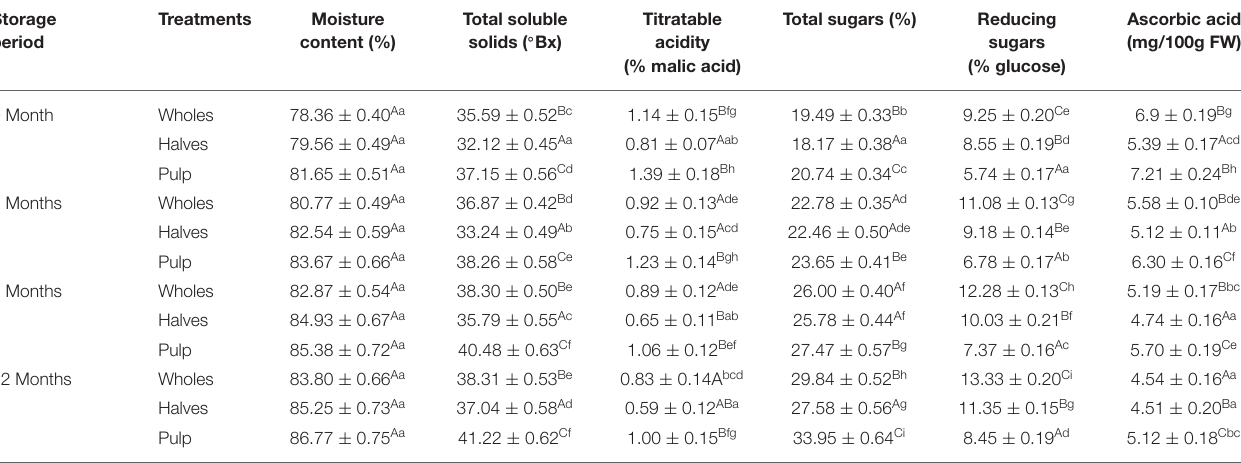
TABLE 1 | Effect of canning and storage on physiochemical properties of canned apricot wholes, halves and pulp. Storage period